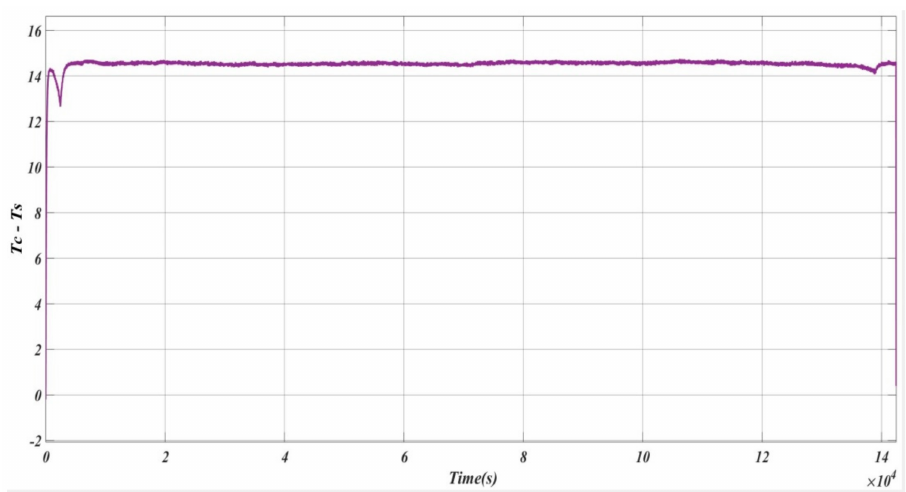
Figure 16. Variation of the difference between the estimated T c and measured T s .